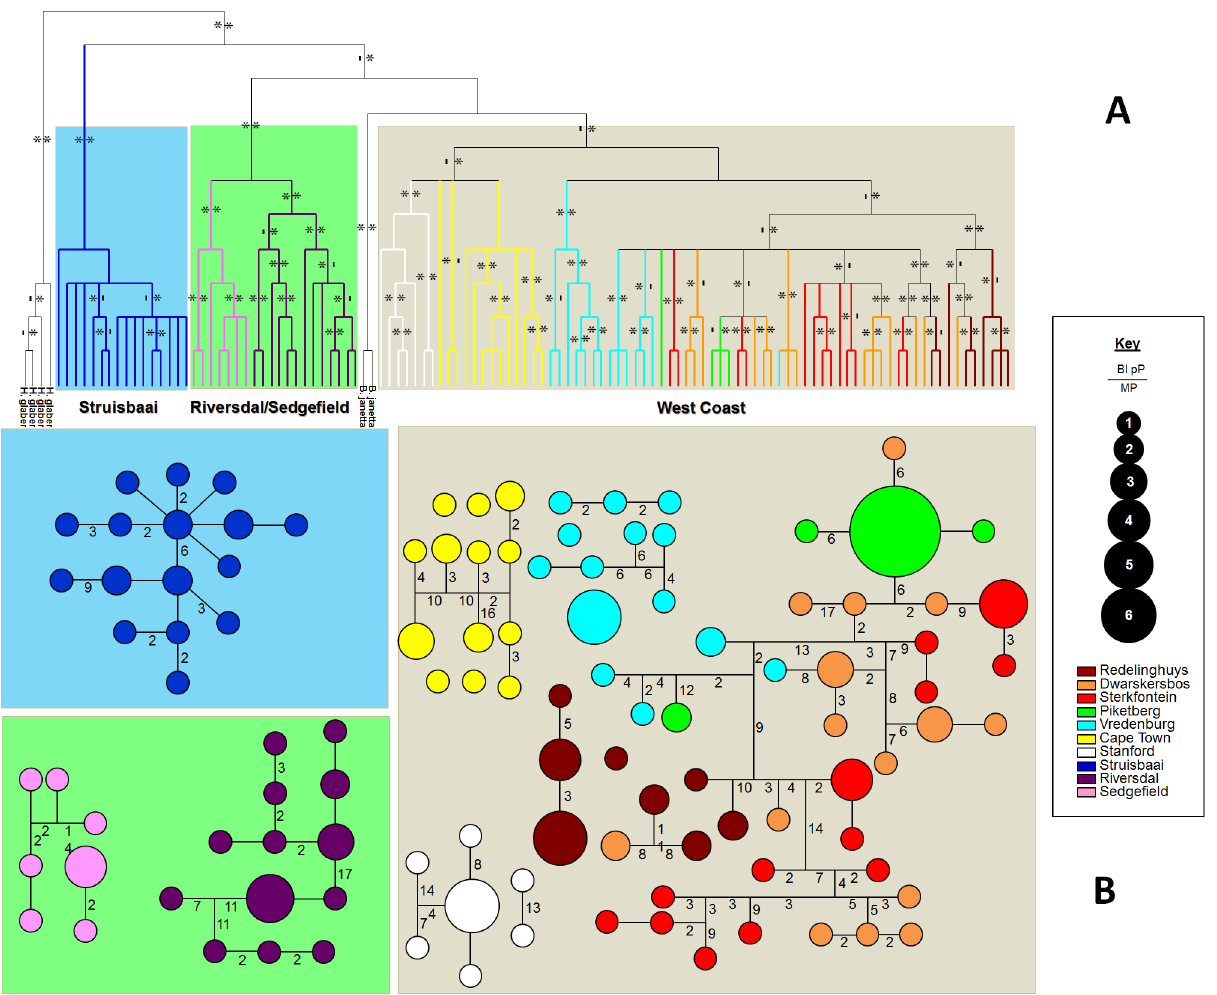
Figure 2 . Bayesian phylogram and haplotype network demonstrating the different mitochondrial DNA clades across the sampled distribution. Figure 2A) Bayesian phylogram and B) haplotype networks obtained from the analyses based on combined cytochrome b and control region sequences demonstrating the different mitochondrial DNA clades detected in B. Suillus from localities across the Cape Floristic Region. For the Bayesian tree, a ‘‘*’’ above each node represent an acceptable posterior probability (pP . 0.90) value derived from the Bayesian inference (MrBayes and BEAST) analyses and those below nodes are the Maximum Parsimony values (MP . 70). A ‘‘-’’ indicate that the grouping was not found by the particular analysis. For the haplotype network, the size of each circle reflects the number of specimens with a particular haplotype. Numbers on branches represent the mutational steps separating haplotypes.